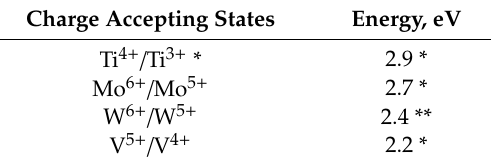
Energy position of levels involved in the charge storage in TiO 2 / MoO 3 , TiO 2 / WO 3 , and TiO 2 / V 2 O 5 photocatalysts (energy is measured against the valence band of semiconductor). Charge Accepting